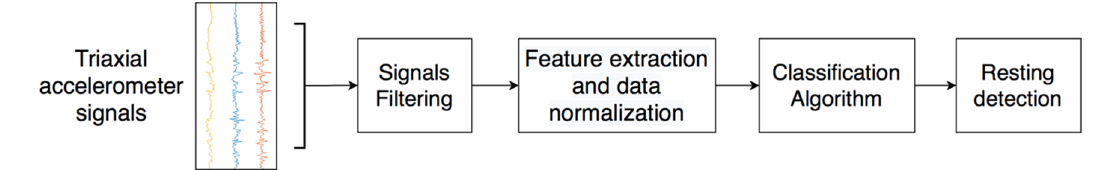
Figure 5. Algorithm for the context classifier using machine and deep learning techniques.